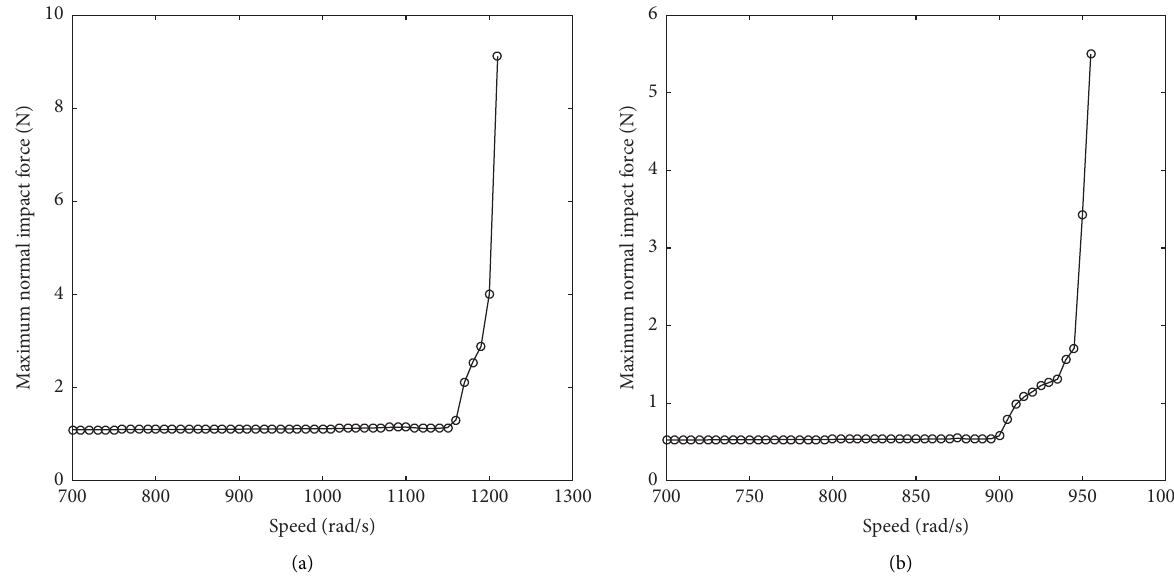
Figure 16: Maximum normal impact forces of the MSDS with K